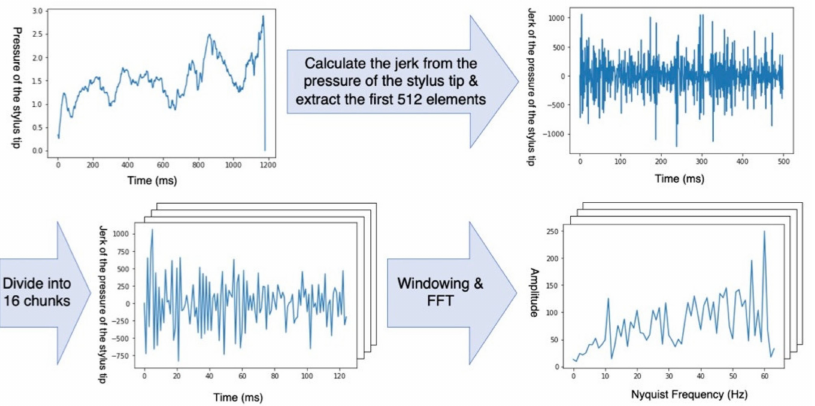
Figure 2. We calculated the jerk from the time-series data of pressure of the stylus tip and extracted the first 512 elements, then applied the Hanning window function and fast Fourier transform (FFT).